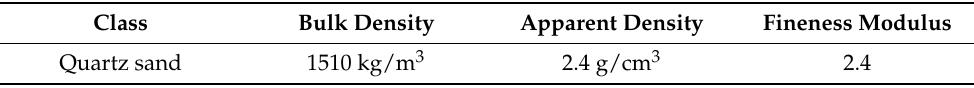
Table 2. The main technical properties of quartz